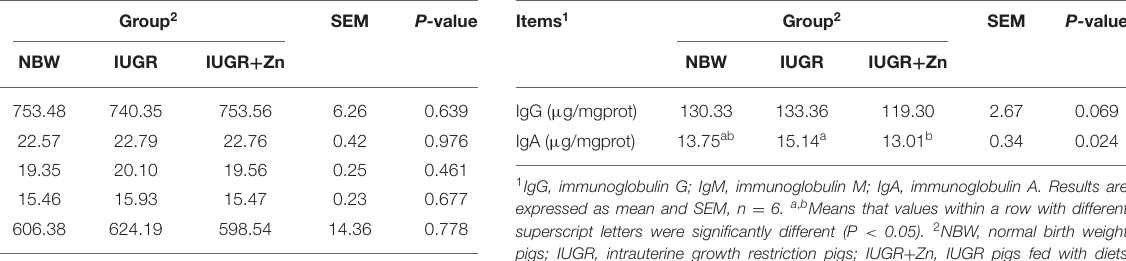
TABLE 6 | Effects of dietary Nano-ZnO supplementation on immune status of jejunal mucosa in IUGR finishing pigs. Items